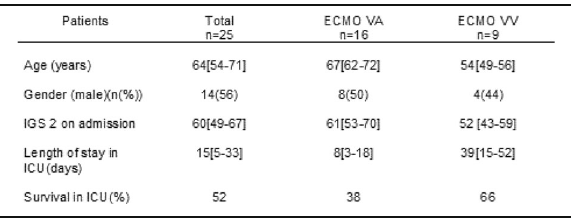
Table 1 (abstract 0296). Population of the study